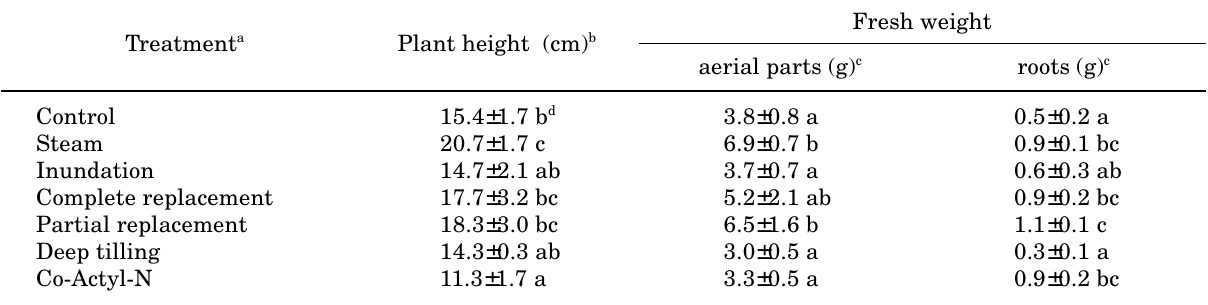
Table 2. Effect of various soil treatments on “stanchezza” (soil sickness) of sweet basil. Results are expressed as plant height and f wt of the roots and aerial plant organs 60 days after sowing on January 30, 1996 (Trial 2, first cycle).